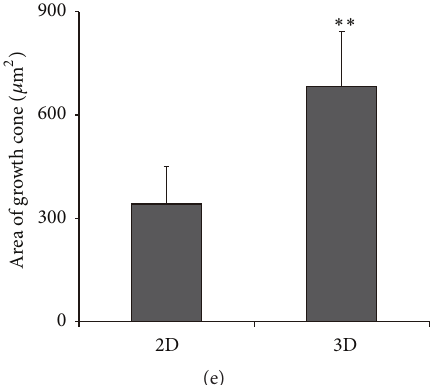
Figure 5: 3D culture affected the growth of growth cones. (a) The diagram of the assay. (b) Morphology of the SGNs growth cone cultured in 2D and 3D systems. Phalloidin, green; 𝛽 -tubulin, red. (c) Quantification of the average number of filopodia per growth cone. (d) Quantification of the average length of filopodia from the edge of the growth cone to tips of each filopodia. (e) Quantification of the average area per growth cone. ∗ 𝑝 < 0.05 and ∗∗ 𝑝 < 0.01